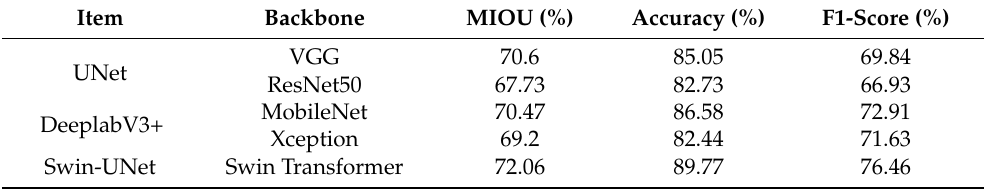
Table 2. Performance comparison of different methods in Sentinel-2 images 10-categories segmentation *.